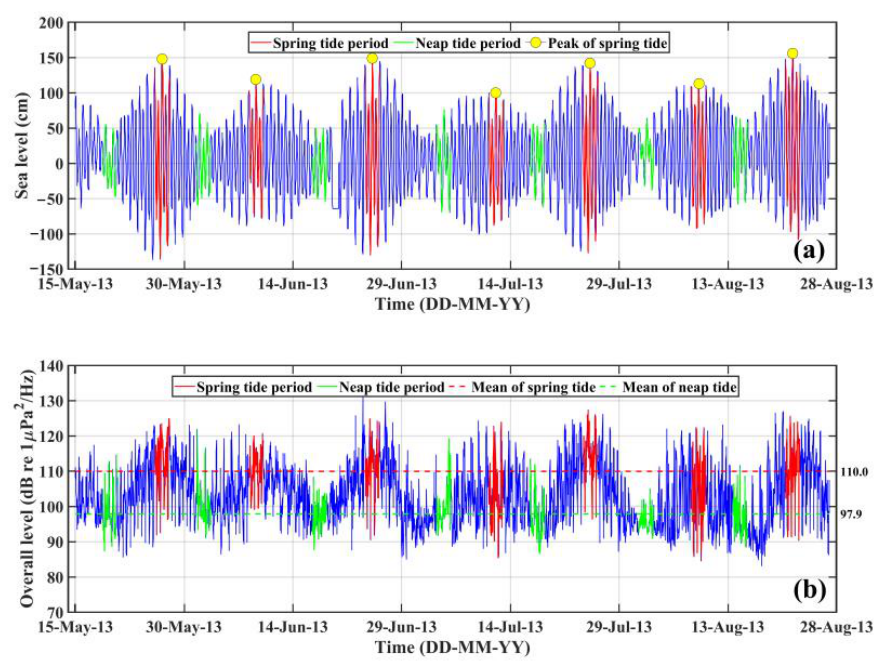
Figure 3. ( a ) Sea level and ( b ) overall level of underwater noise from 15 May to 27 August 2013. The red and green lines indicate spring tide and neap tide periods, respectively. Yellow points indicate the peaks of the spring tide. The number at the end of the red dotted line is the average for the spring tide, and the number at the end of the green dotted line is the average for the neap